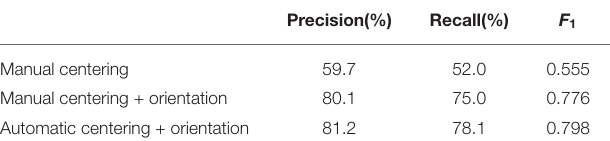
TABLE 5 | Performance of the detection of the event “entrance with pollen.”